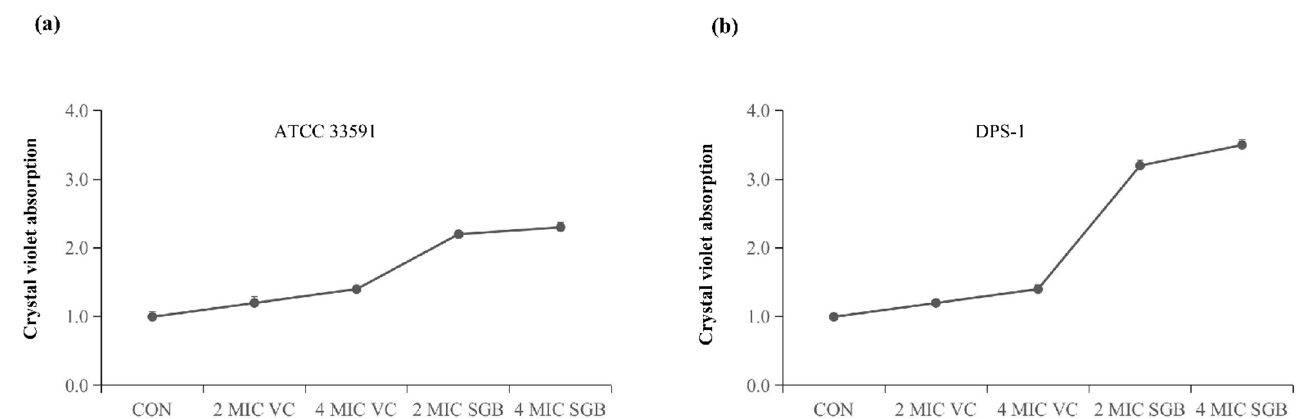
Figure 3. Crystal violet absorption of SGB and vancomycin-treated S. aureus ; vancomycin was used as a negative control. ( a ) The crystal violet absorption of S. aureus ATCC 33591 treated with 2 MIC and 4 MIC of SGB or vancomycin. ( b ) The crystal violet absorption of S. aureus DPS-1 treated with 2 MIC and 4 MIC of SGB or vancomycin. SGB, sanguisorbigenin; VC, vancomycin. The data are presented as the mean ± standard deviation of three independent experiments.